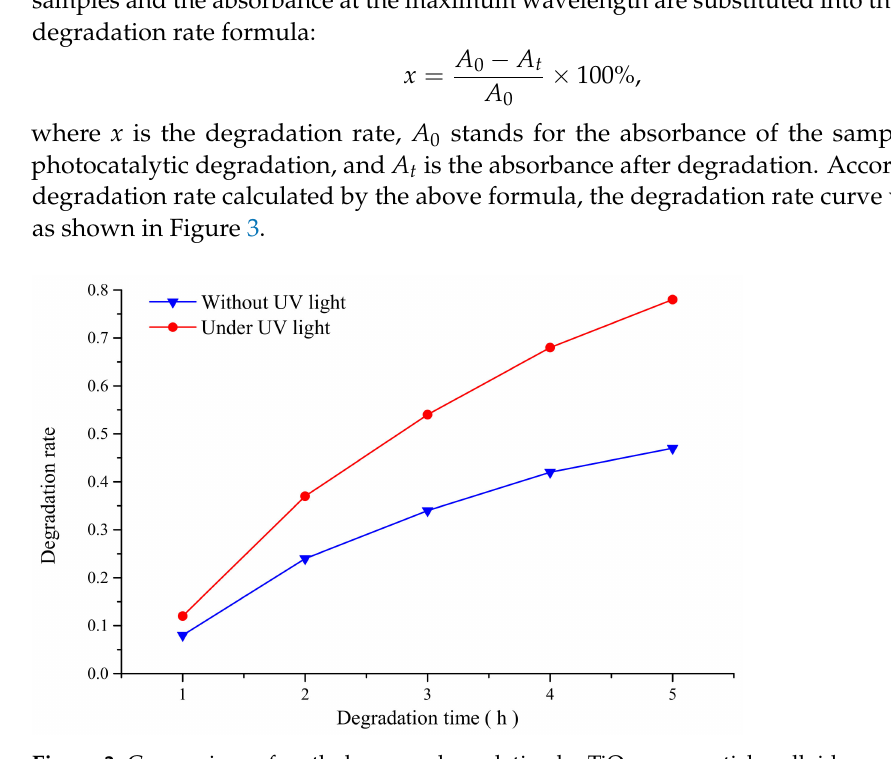
Figure 3. Comparison of methyl orange degradation by TiO 2 nanoparticle